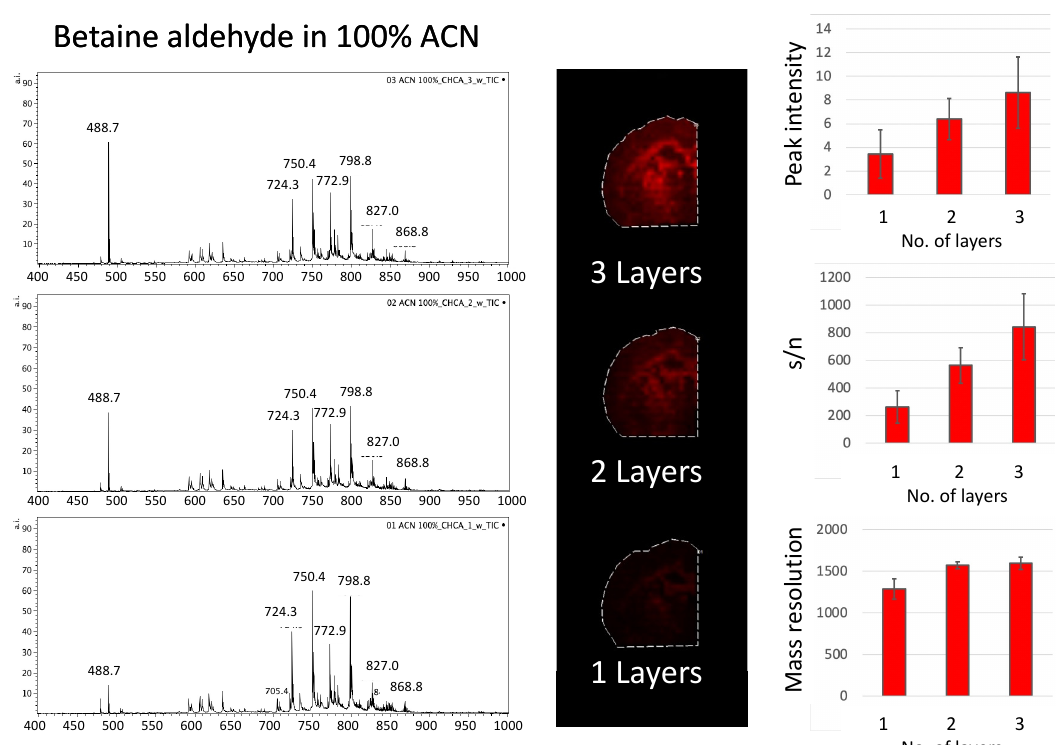
Molecules 2021 , 26 , 2737 Figure 4. The influence of the number of layers of betaine aldehyde in 100% of acetonitrile on obtained mass spectra.